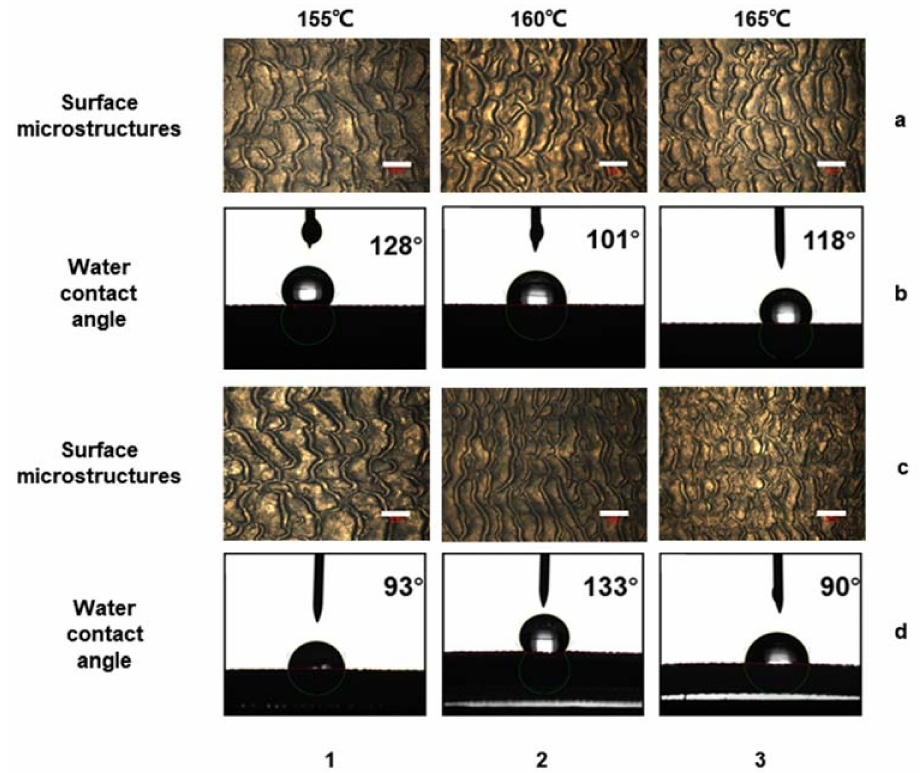
Figure 5. ( a ) When LLDPE/AC15 (9:1) was used as the material and the screw speed was 80 r/min, the changes in the morphology and water contact angle of the prepared sample with temperature on the micrometer scale ( b ). ( c ) When LLDPE/AC5 (9:1) was used as the material and the screw speed was 80 r/min, the changes in the morphology and water contact angle of the prepared sample with temperature on the micrometer scale ( d ). The scale bar in the illustration ( a , c ) was 400 µ m. (1–3) showed the die temperature was 155 ◦ C, 160 ◦ C, 165 ◦ C